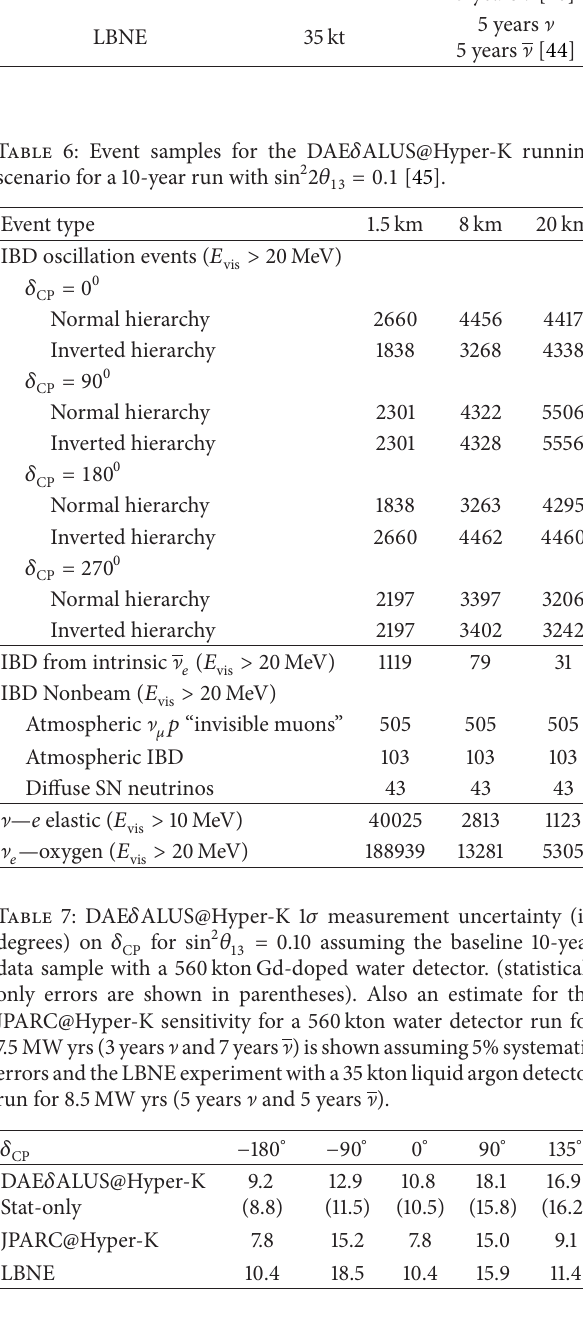
Table 6: Event samples for the DAE 𝛿 ALUS@Hyper-K running